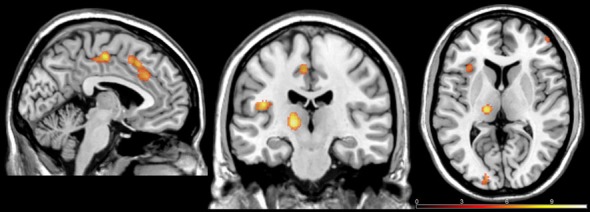
Brain regions exhibiting activation in the Pain > No Pain at p < 0.05 family-wise error corrected (FWE)-corrected.